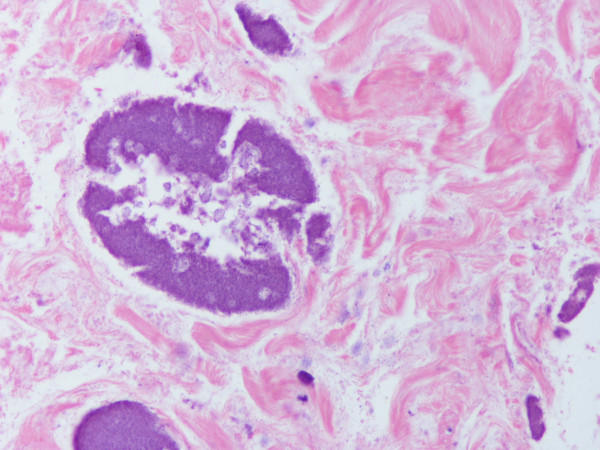
The histological examination of the removed specimen (right hemicolectomy specimen) revealed actinomyces colonies in the upper part of the cecum and the ascending colon wall. The large spherical clusters, densely packed and branching, and PAS positive "sulfur granules" are specific of actinomycosis.